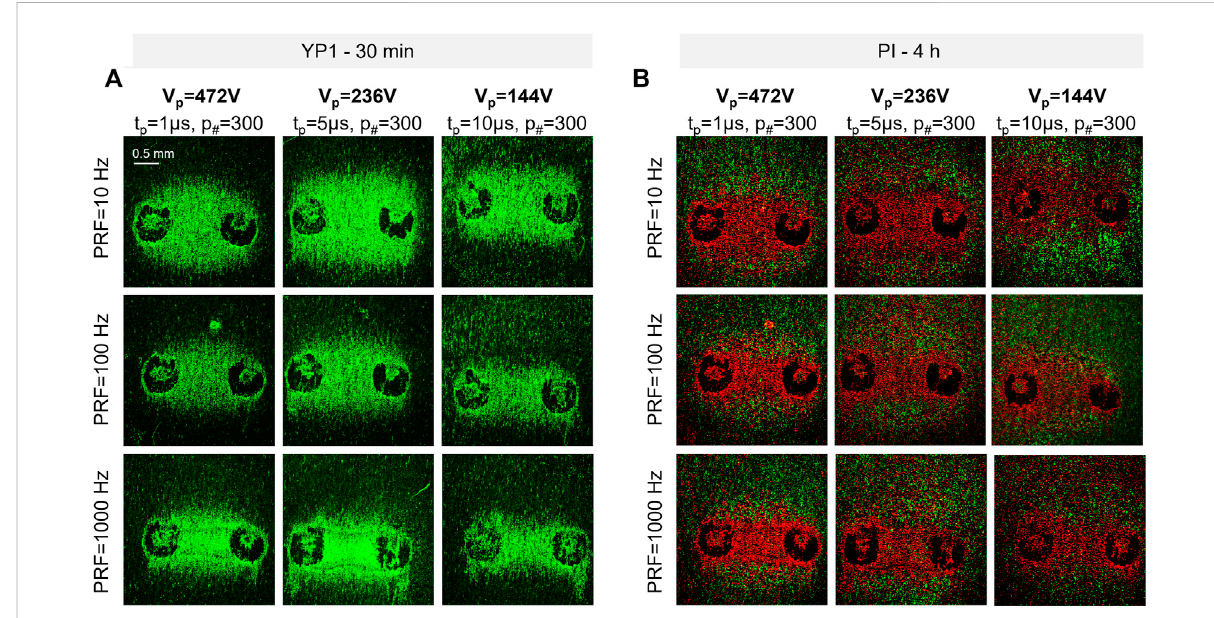
Representative fl uorescent images of PEF-induced electroporation in hiPSC-CM monolayers (A) The green areas between the electrodes correspondto thelocationofelectroporatedhiPSC-CMmonolayers 30 minafter treatment. (B) Theredareabetweentheelectrodes correspondto thelocationofdeadhiPSC-CMs4 haftertreatment.Thegreenstainingattheedgeoftheelectroporatedarea4 haftertreatmentcorrespondstothe reversibly electroporated cells. The 488 laser intensity was different in A and B to highlight YP1-stained cells at 4 h, thus background fl uorescence is more evident in (B) . Two black circles on each image represent the imprints of the